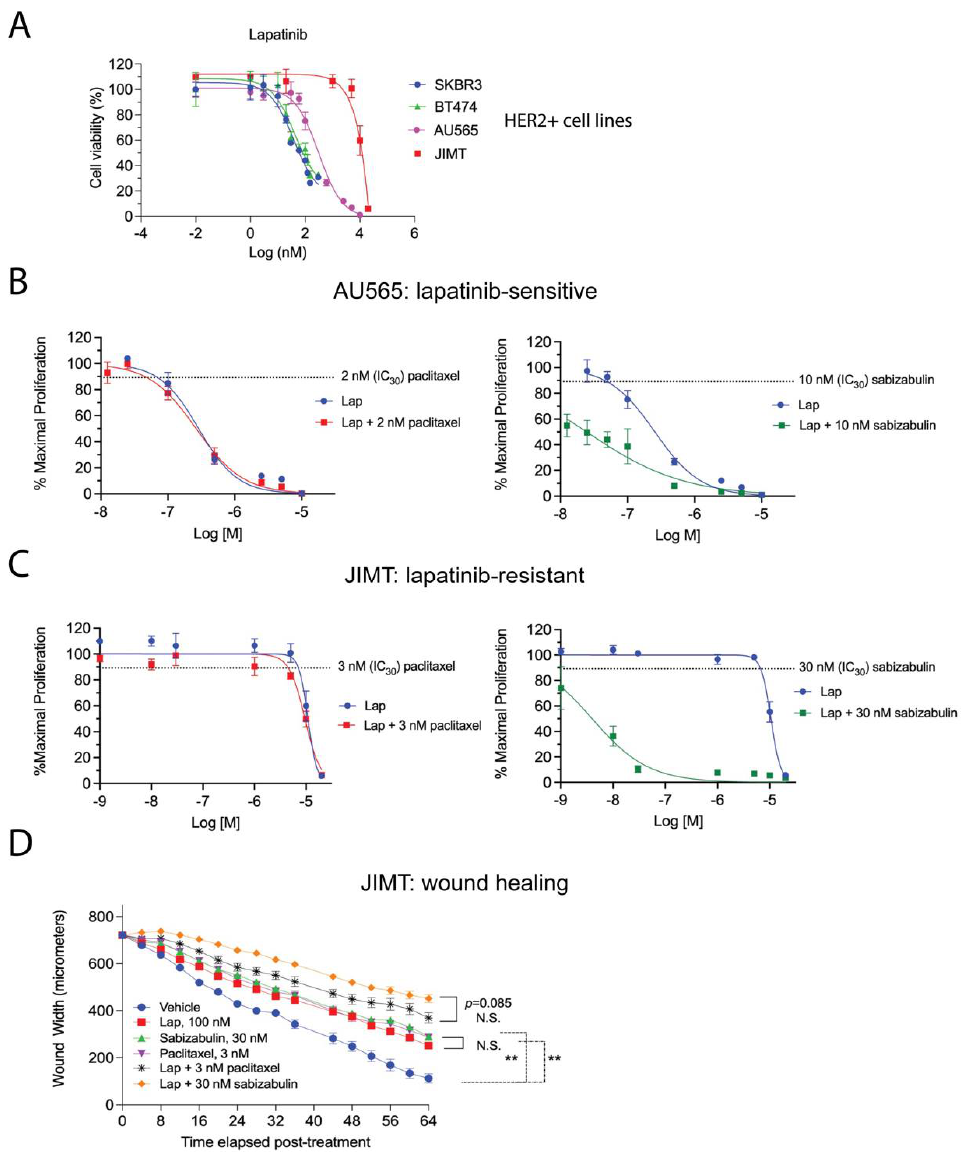
Figure 7. Efficacy of the combination of either paclitaxel or sabizabulin with lapatinib on cell growth inhibition and wound healing. ( A ) Lapatinib sensitivity of BT474, SKBR3, AU565 and JIMT HER2+ cell lines was measured by the MTS assay over a range of doses, data enumerated as a percentage of viable cells, and plotted on log (nM) scale, confirming that JIMT cells are lapatinib-resistant. ( B , C ) The MTS assay was used to determine the effect of pairing lapatinib (Lap) with paclitaxel (left panels) or sabizabulin (right panels) in AU565 ( B ) or JIMT ( C ) cells by the isobole method; the effect of the anti-tubulin targeting agent alone at the IC 30 dose is shown as a dashed line. ( B , C ) Data are plotted as the % maximal proliferation on a log scale (M = molar) after normalization to the untreated control as described in the Materials and Methods. Assays in ( A – C ) are representative of 3 to 4 biological replicates. ( D ) Wound healing was assayed by measuring wound width over time after drug added using the IncuCyte S3 instrument. JIMT cells were treated with either lapatinib (Lap), sabizabulin or paclitaxel alone, or in combination with 100 nM of lapatinib (n = 8 wells/cell line/treatment). Data are representative of two biological replicate experiments. ** p < 0.01; N.S., not